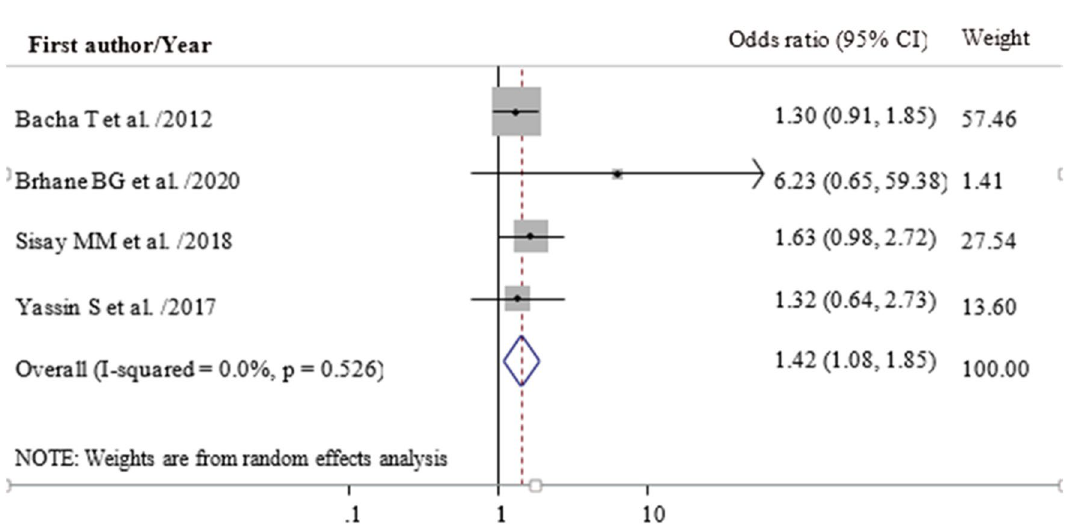
Figure 4. Forest plot of adjusted odds ratio showing the association between having drug substitution and treatment failure among children in Ethiopia, 2020.